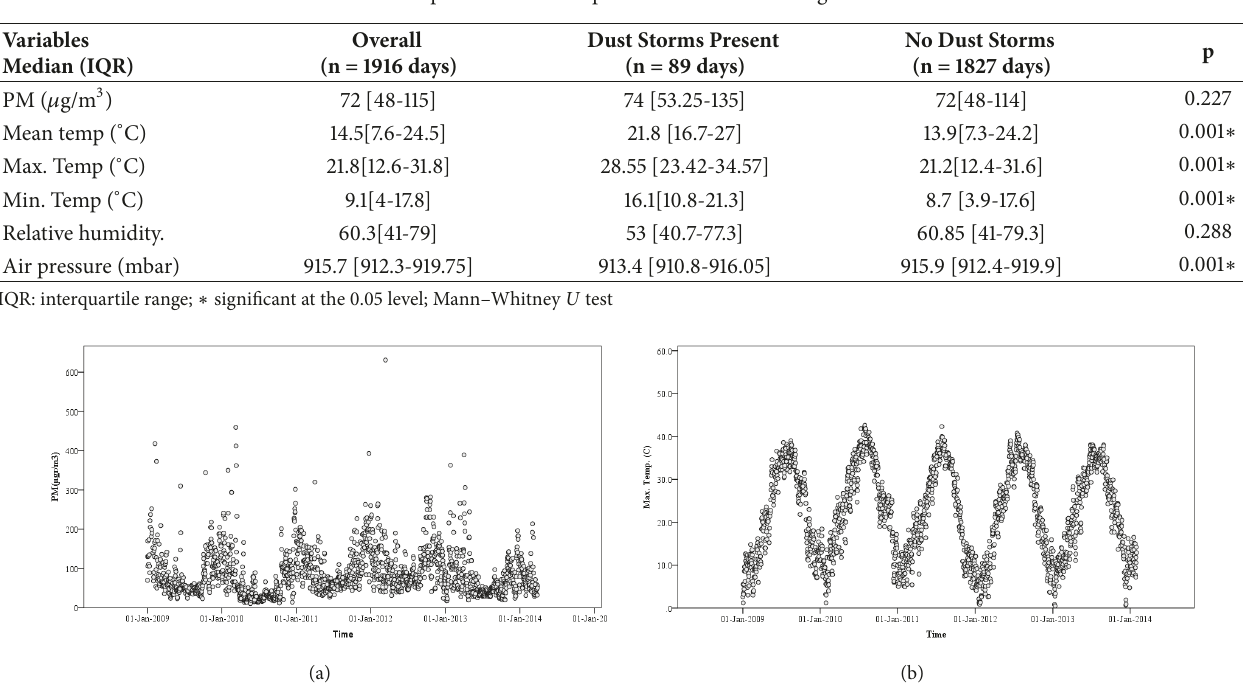
Table 1: Descriptive statistics for pollutants and meteorological variables.